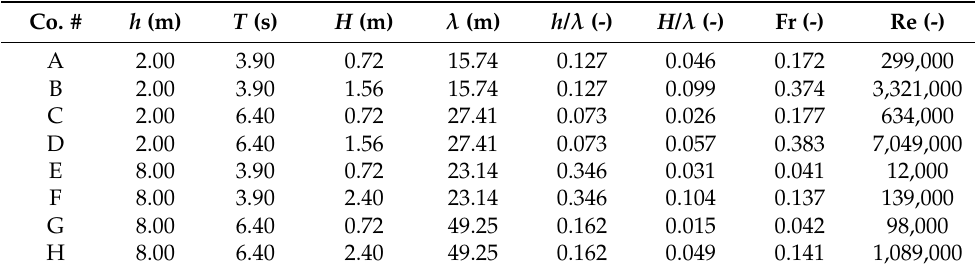
Table 2. Hydrodynamic parameters for the prototype-reef structure.